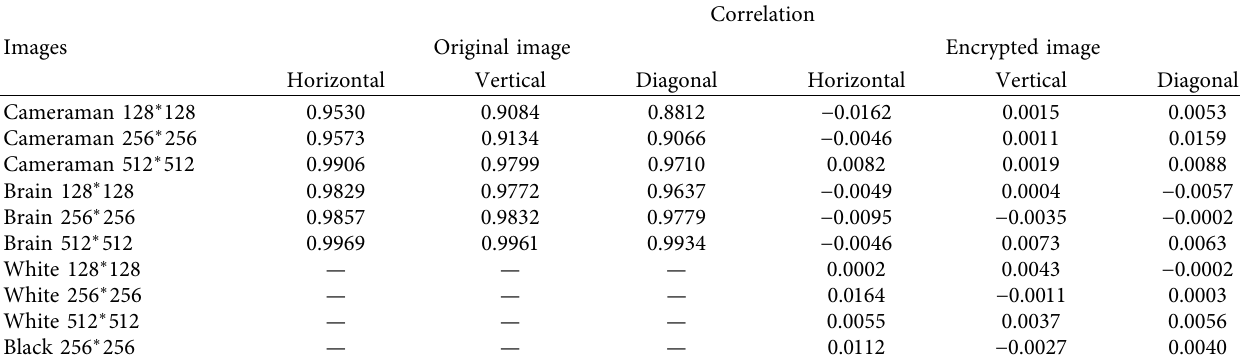
Figure 7: Correlation analysis of the cameraman plain image and cipher image in three directions. (a) Horizontal correlation of the cameraman plain image. (b) Vertical correlation of the cameraman plain image. (c) Diagonal correlation of the cameraman plain image. (d) Horizontal correlation of the cameraman cipher image. (e) Vertical correlation of the cameraman cipher image. (f) Diagonal correlation of the cameraman cipher image. Table 8: The correlation coefficients of the images in different